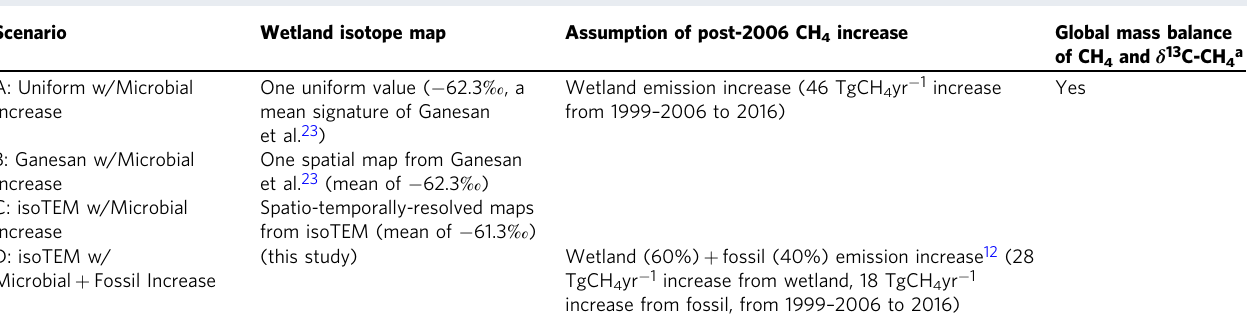
Table 1 Setup of TM5 atmospheric modeling for Scenarios A –